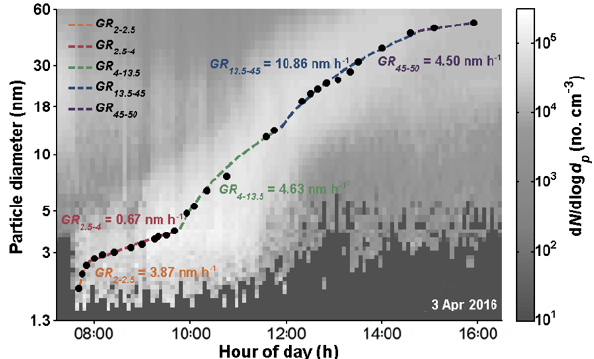
Figure B2. Size- and time-dependent growth rate on an NPF day observed in Beijing. Representative diameters are obtained by log- normal fitting of nucleation mode particles in each time bin, and GR is linearly fitted in each